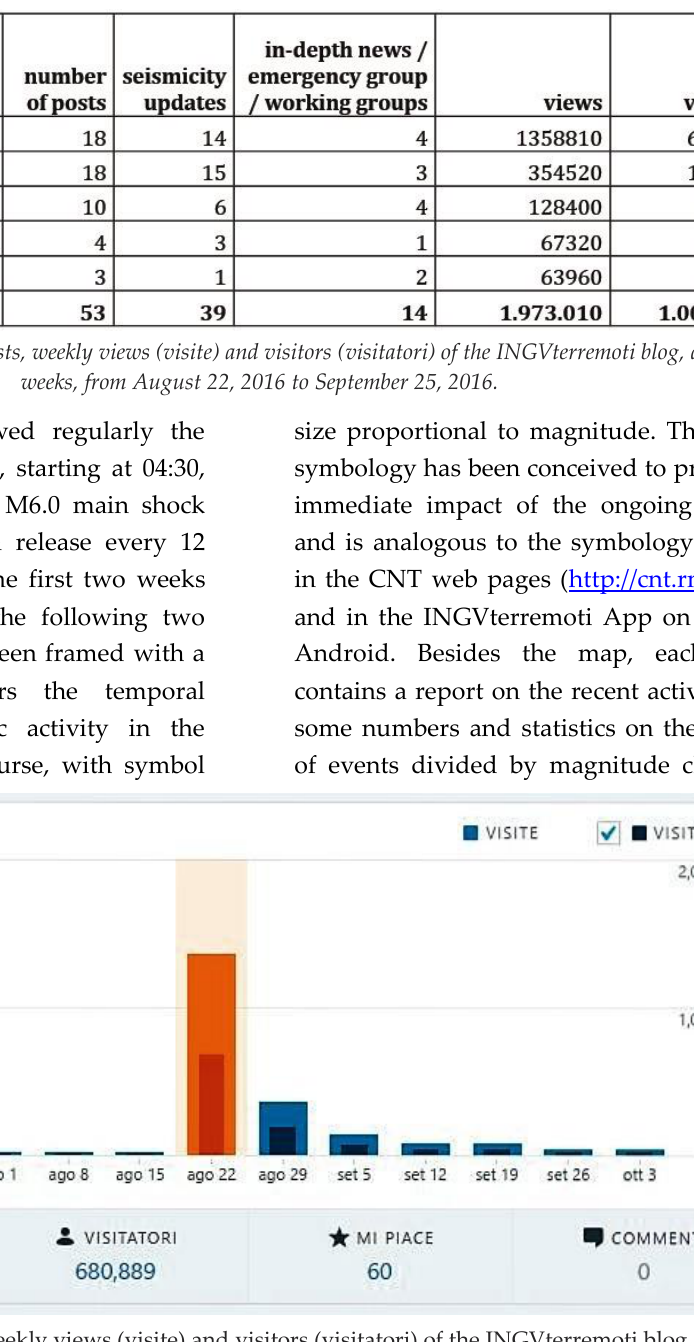
Figure 2 : The number of weekly views (visite) and visitors (visitatori) of the INGVterremoti blog, during 13 weeks, from July 11, 2016 to October 3, 2016. The week 22-28 August (in red) shows the peak in the number of views (1,358,808) and visitors